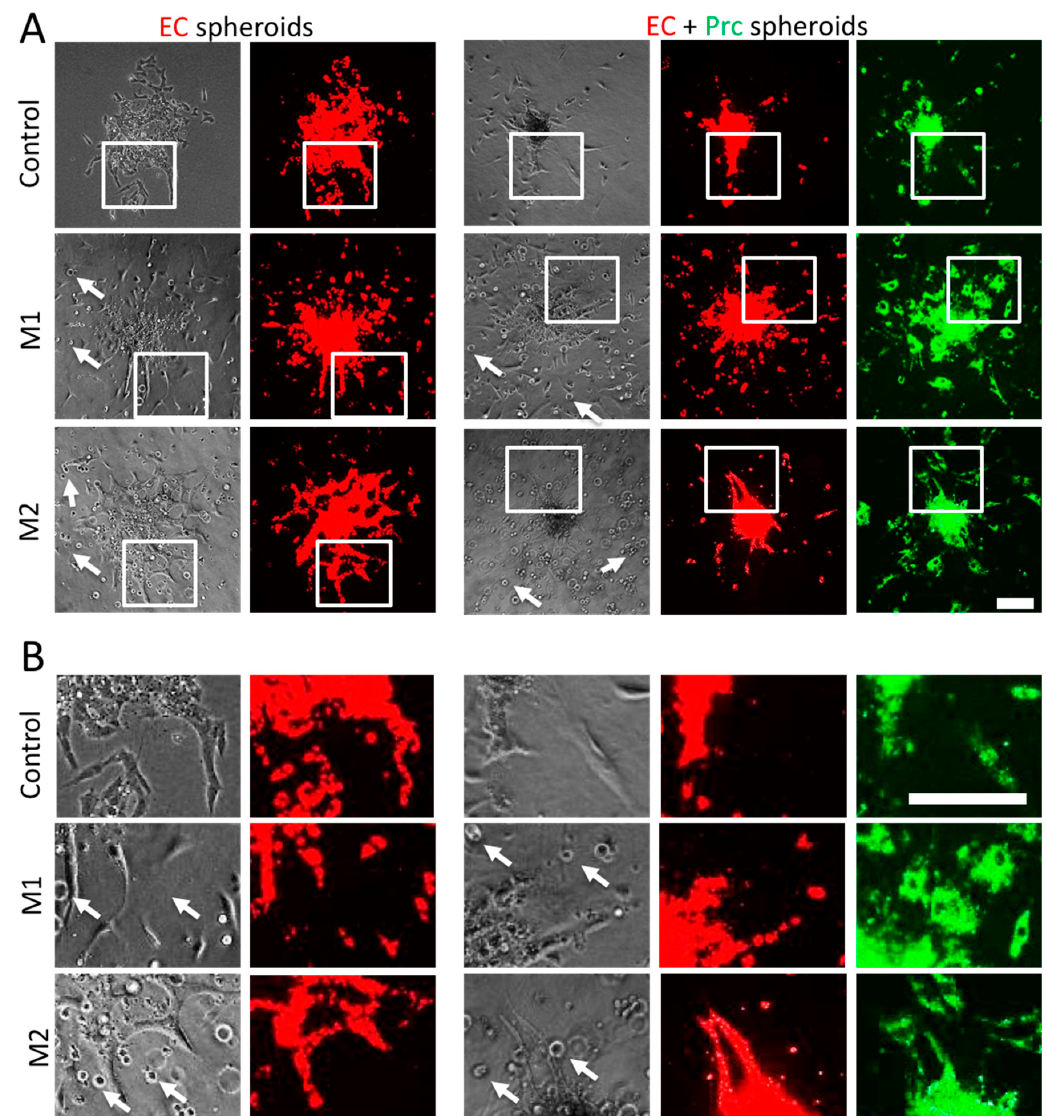
Figure 2. Endothelial cell (EC) sprouting assay in the presence of polarized macrophages. ( A ) Representative images of EC (red) spheroids with and without pericytes (Prcs, green), which were induced to sprout suspended with M1 and/or M2 macrophages. ( B ) Corresponding magnified images from panel A as indicated by white frames. Macrophages appear as small round cells suspended in the collagen I hydrogel and example cells are pointed at by white arrows. Scale bars: 200 µm. Endothelial cells sprouted in all conditions. As reported previously [17], the presence of pericytes within endothelial cell spheroids drastically reduced endothelial sprouting and maintained spheroids with a cell-dense core (Figure 2, controls). Pericytes were located in the cell-dense cores and at formed endothelial sprouts (Figure 2). Macrophages suspended into the collagen I hydrogels appeared evenly distributed in the hydrogels as small round cells (Figure 2, also indicated by white arrows). Suspension of pro-inflammatory M1 macrophages around seeded spheroids did not enhance endothelial